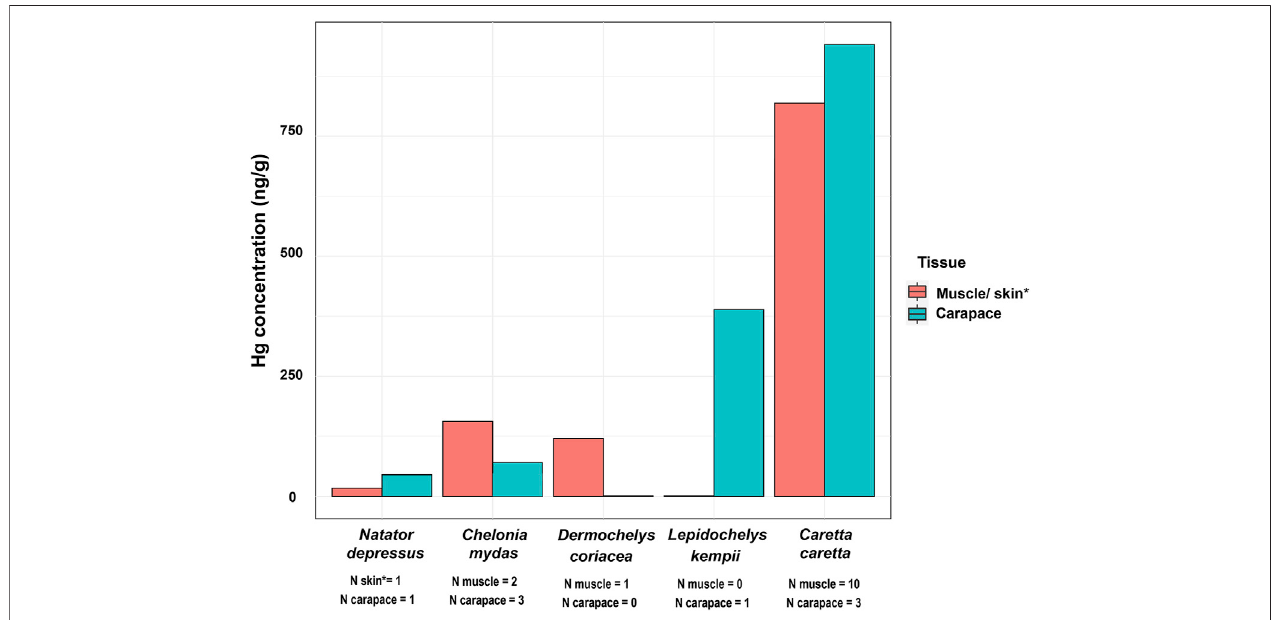
FIGURE 5 | Average Mercury (Hg) concentration (ng/g) in muscle/skin and carapace of sea turtle species worldwide (based on Table 2 ).